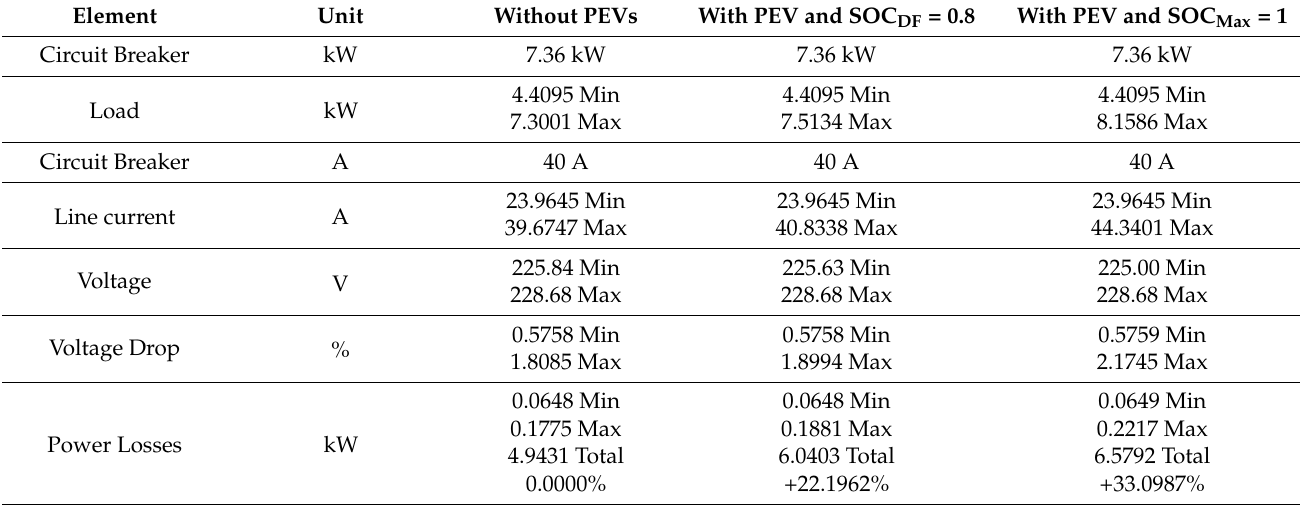
Table 5. Power demand and loss, current and voltage at home (flat rate).